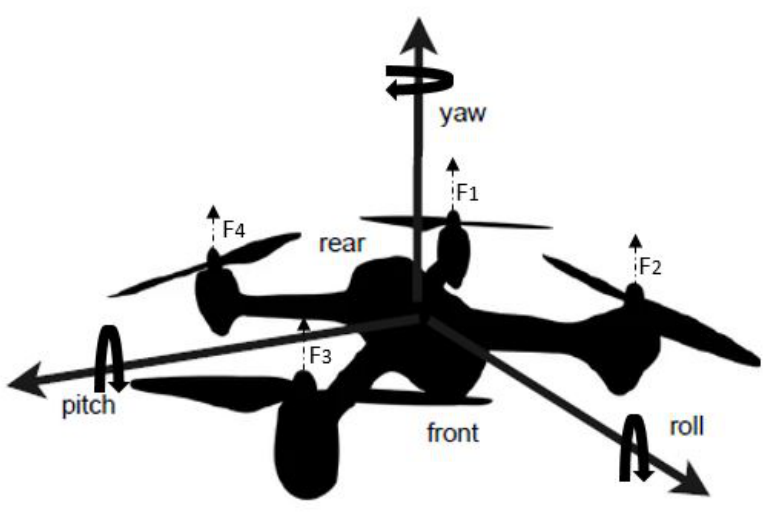
Figure 3. UAV quadrotor